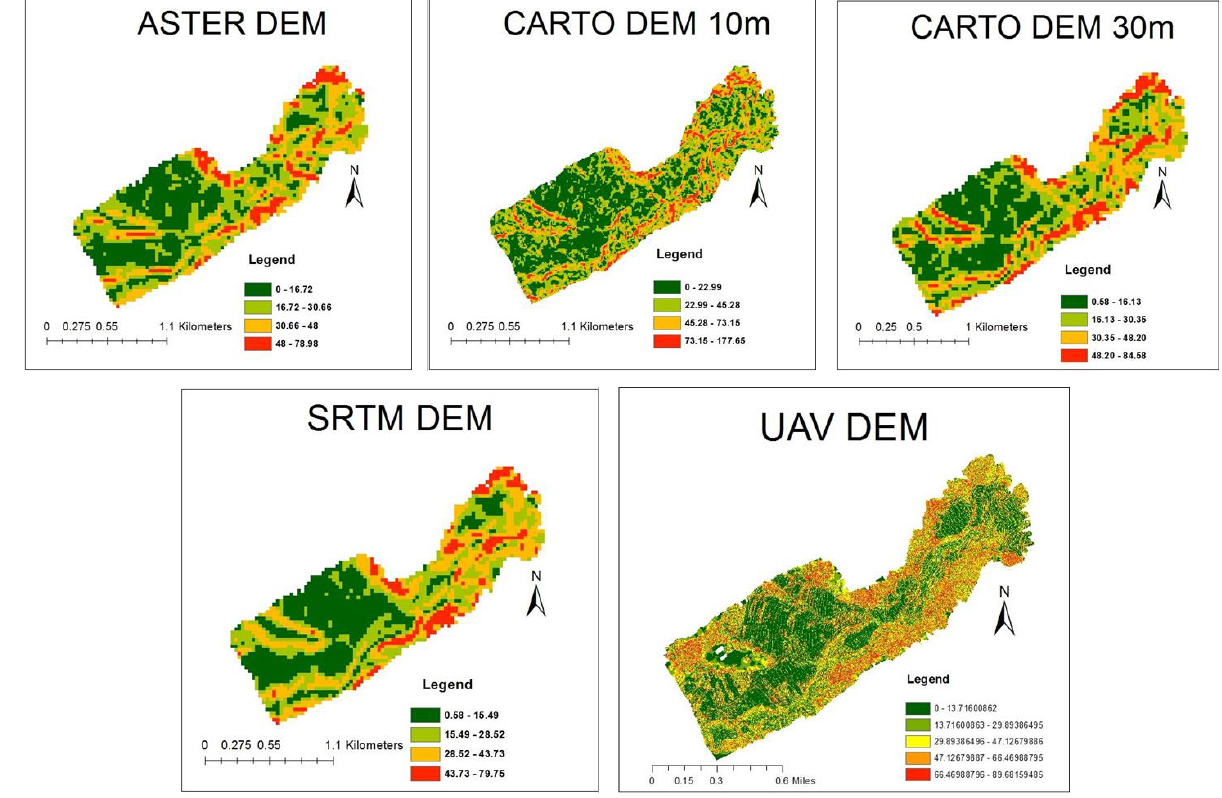
Figure 2: Slope maps dervied using different DEMs